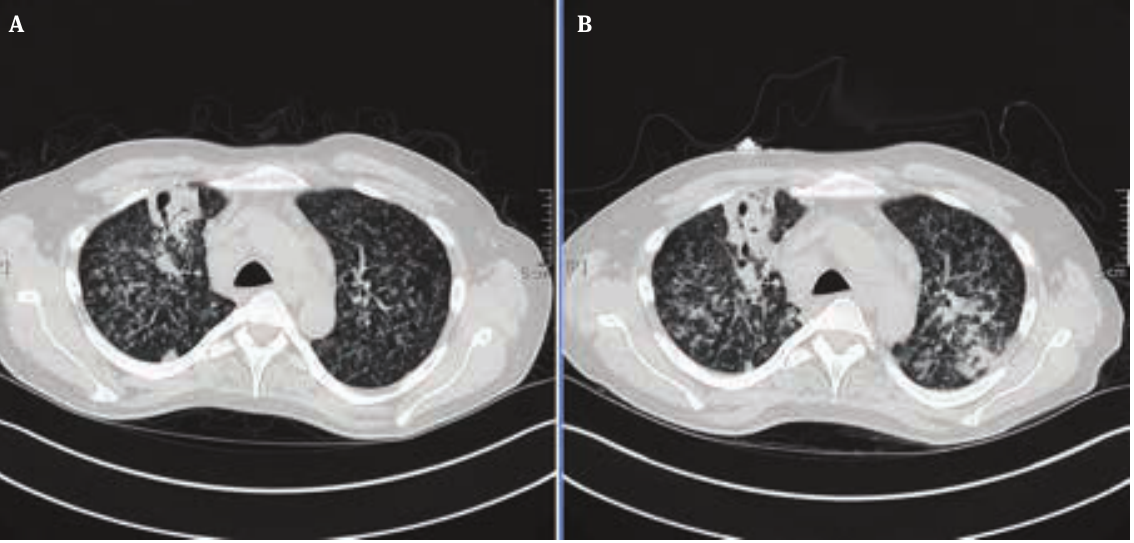
Figure 4: A. Contrast enhanced CT- Scan of follow- up control 2 weeks after the first course of anti- tuberculous therapy. B: Contrast CT- Scan of follow- up control 6 weeks after the discontinuation of adalimumab therapy showed progressive pulmonary infiltrates on both sides in term of paradoxical